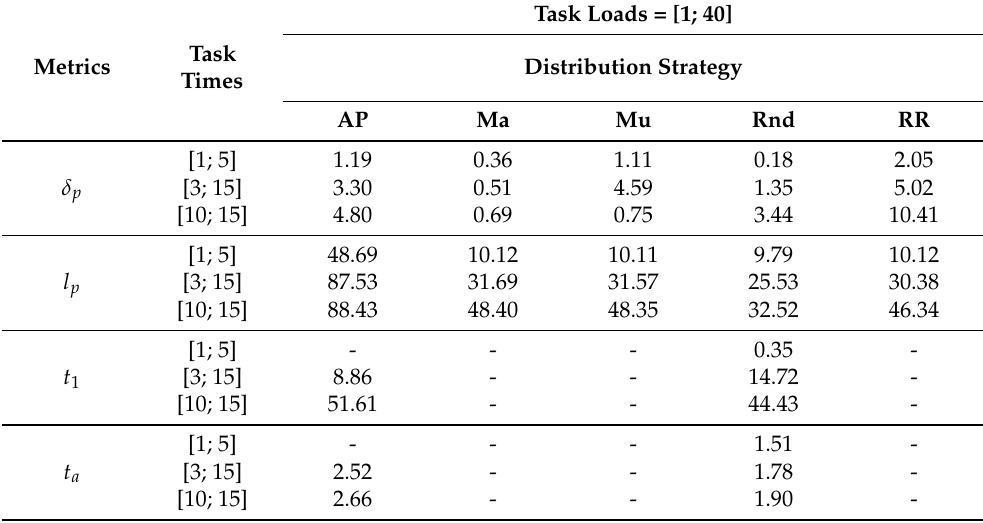
Table 4. Statistics for tasks with a variable amount of required processing power and various required times.